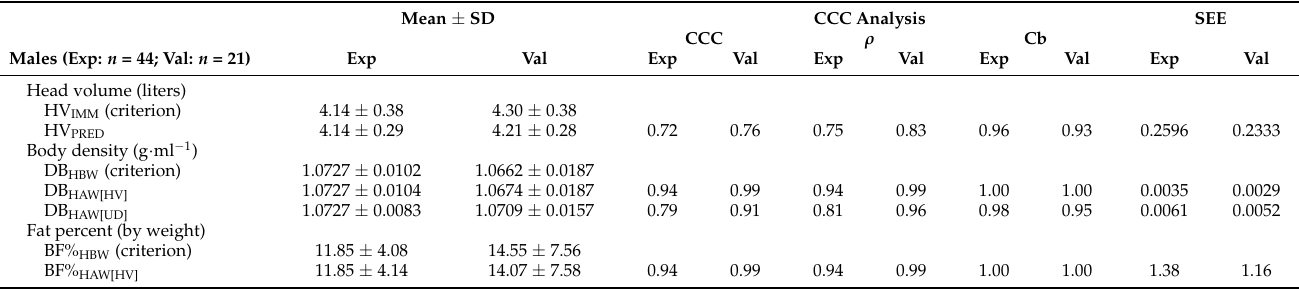
Table 2. Means, correlations, and standard errors for predicted head volume, body density, and fat